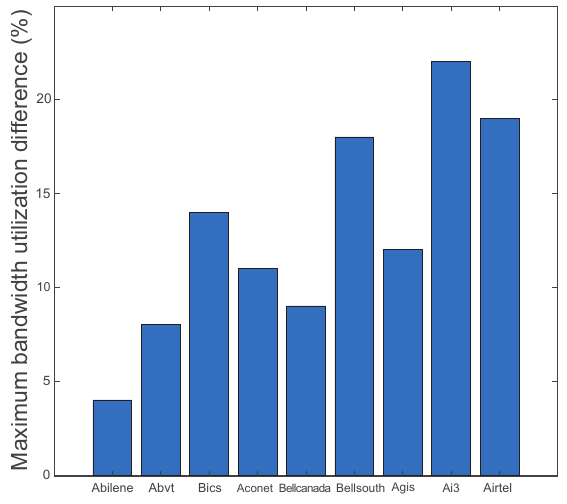
Fig. 9 Bandwidth difference for changing degrees.